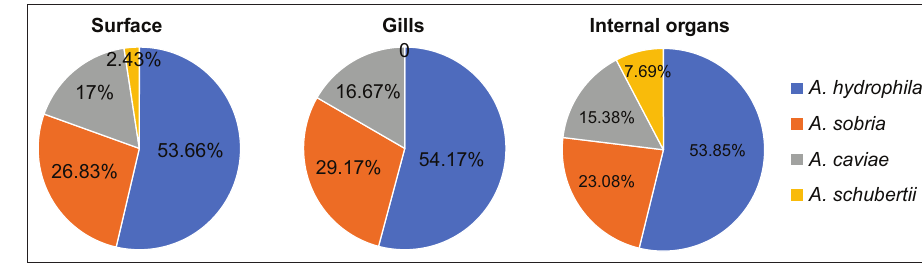
Figure-1: Aeromonas spp. recovered from different swabbing sites of Mugil cephalus.